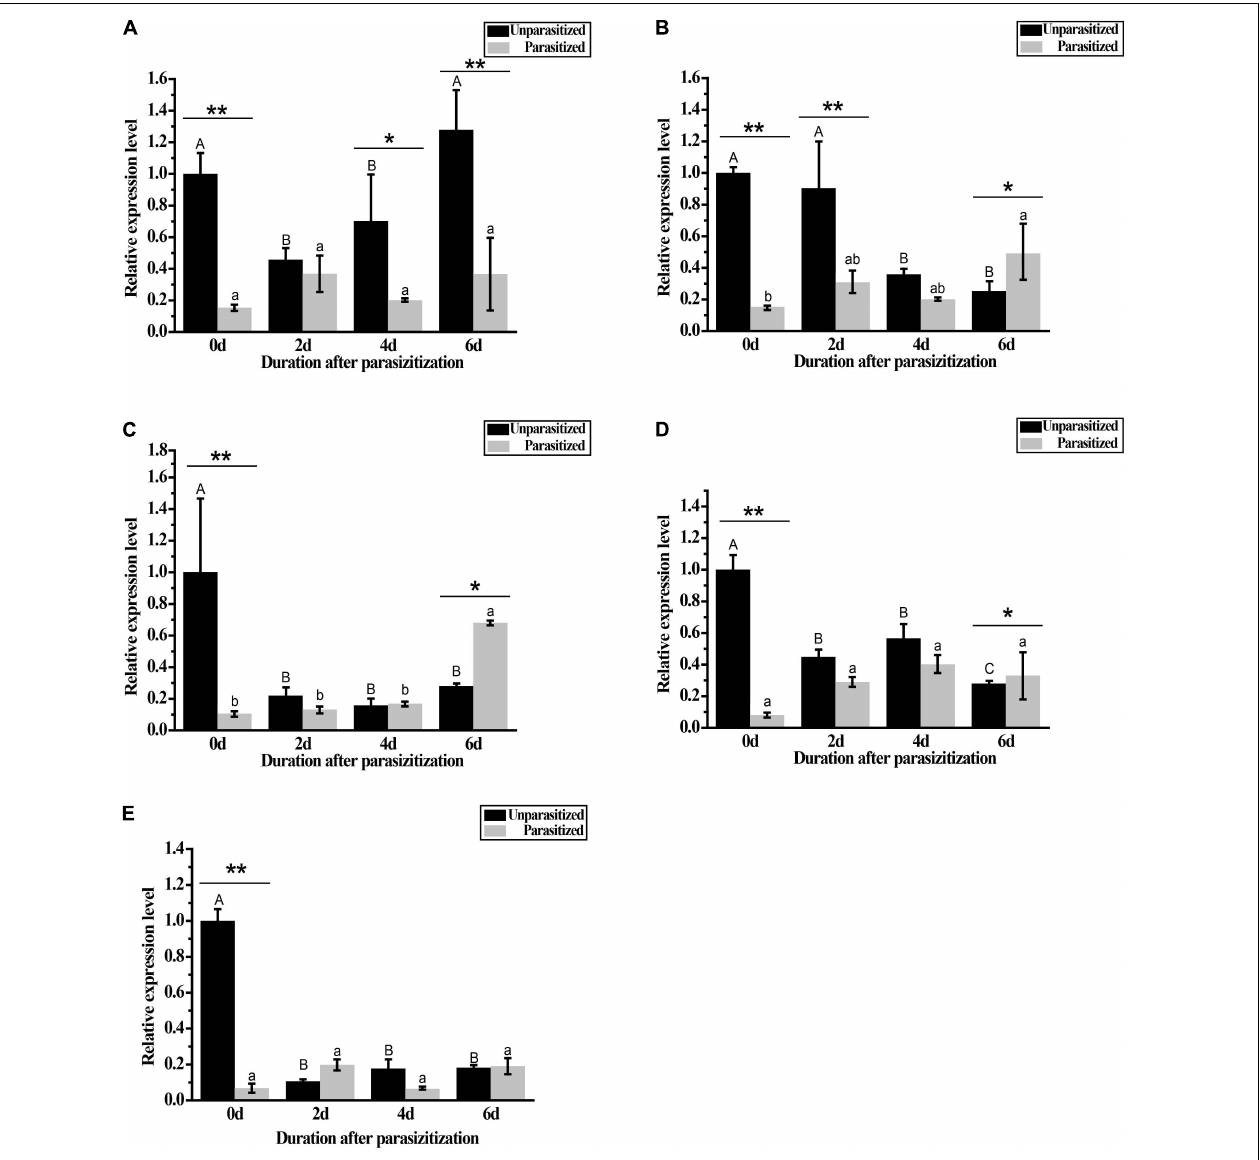
FIGURE 8 | Expressions of GpHsps after parasitization by A. confusum . (A) GpHsp71.3 ; (B) GpHsp74.9 ; (C) GpHsp82.4 ; (D) GpHsp89 ; (E) GpHsp93.4 . The black bar represents the healthy groups and the gray bar represents the parasitization groups. Data are shown as the mean ± SE of three biological replicates. Different upper and lower case letters indicate significant differences between healthy and parasitization groups within the different days ( p < 0.05). Single asterisks ( p < 0.05) and double asterisks ( p < 0.01) indicate significant differences between the healthy and parasitization groups within the same